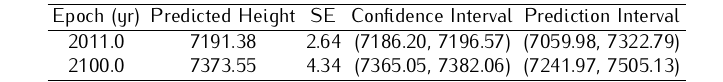
Table 6. Projection statistics for the MSL heights referenced to Fernandina reference level realized at 1975.5. All units are in mm.